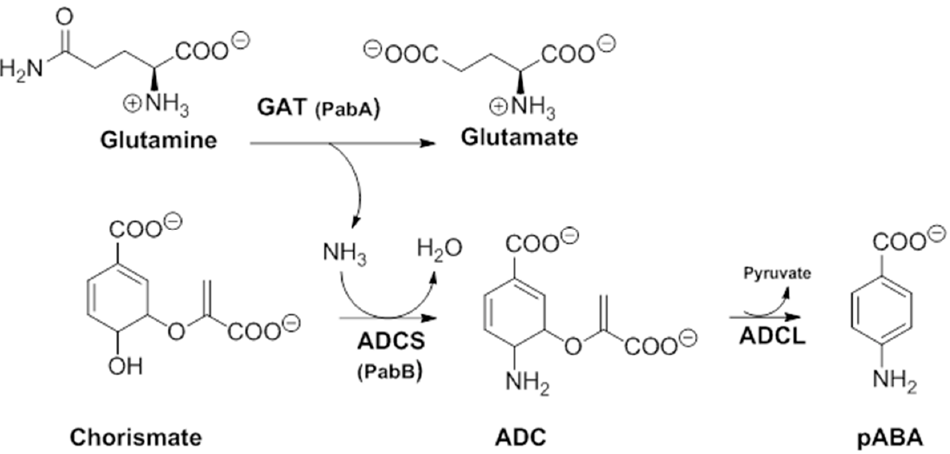
Figure 5. Details of the two-step pathway required for pABA synthesis. In all prokaryotes, the ADC formation requires a bifunctional GAT–ADCS protein, whereas in most prokaryotes, it requires two independent proteins PabA(GAT activity) and PabB (ADCS activity) (modified from [3]). ADC amino-deoxychorismate, ADCL amino-deoxychorismate Lyase, ADCS amino-deoxychorismate synthase, GAT glutamine amido-transferase, pABA para-aminobenzoic acid.